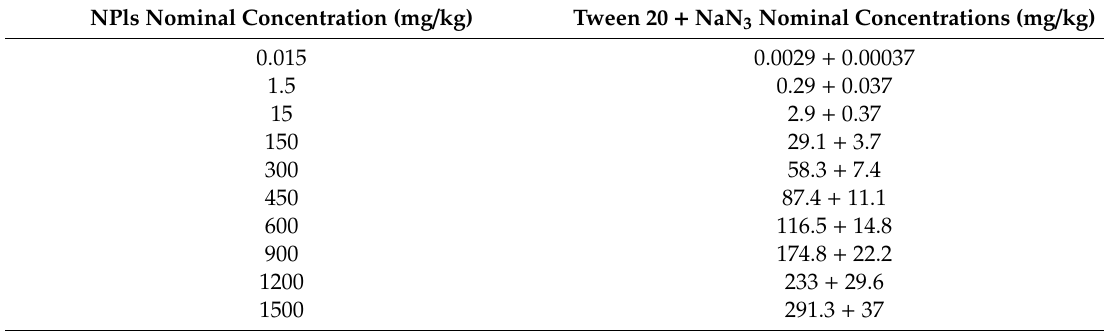
Table 3. Correspondence between the nominal concentrations of polystyrene nanoplastics (NPls) and the nominal concentrations of tween 20 and sodium azide (NaN 3